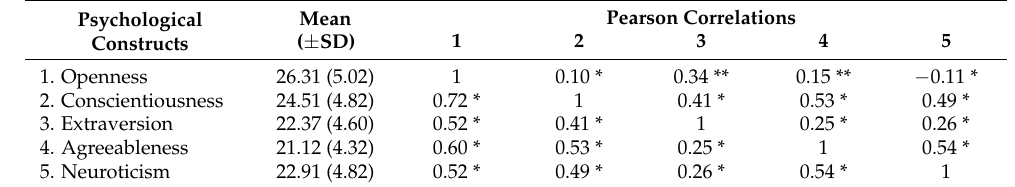
Table 5. Correlation matrix between the personality constructs among the study participants. Num- bers 1–5 of the Pearson’s correlation matrix represent variables as shown in the table’s first